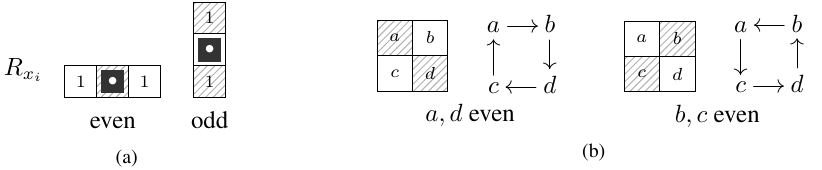
Figure 20: (a) A (2 , 4) and (3 , 6) priority strategy for the breaker for P 4 , 4 . The priorities depend on the parity of the current maker mark. Even cells are shaded. (b) Dependency digraphs of the cells in the placements of P 4 , 4